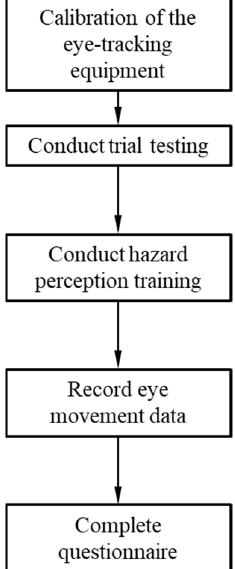
Figure 2. Hazard perception testing.